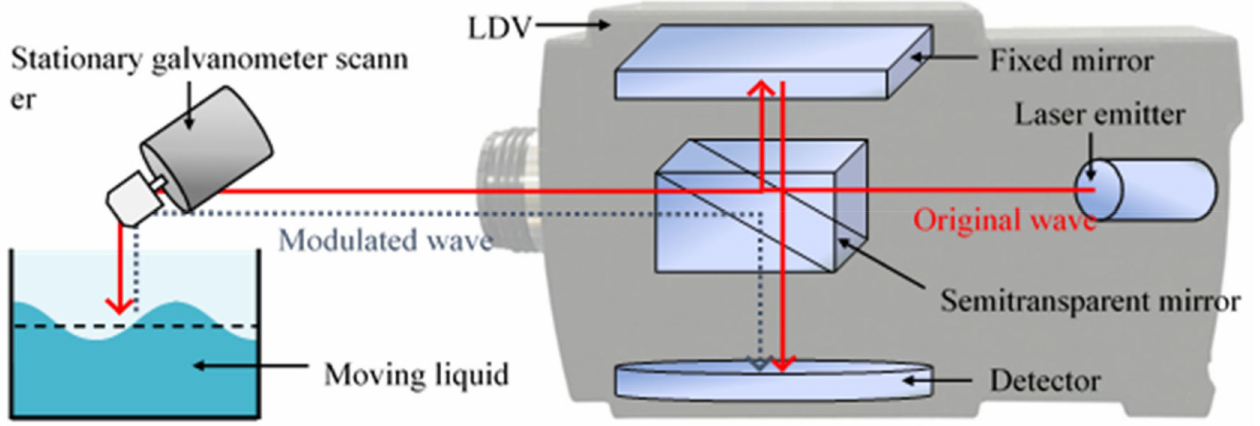
Figure 3. Schematic diagram of moving light in the LDV.